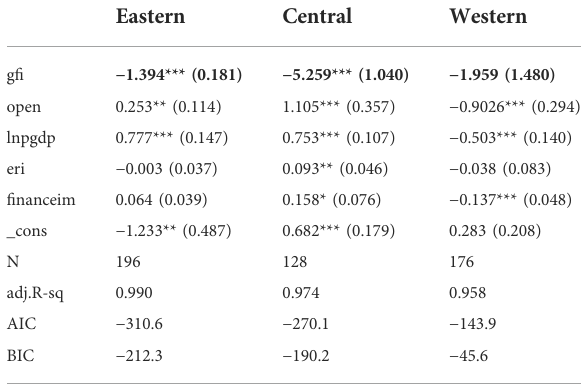
TABLE 12 Regional heterogeneity